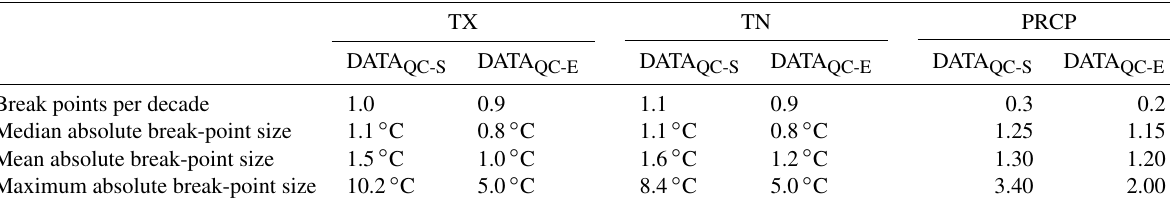
Table 4. Break-point frequencies and break sizes. For minimum and maximum temperature (TX and TN, respectively), absolute break size values in ◦ C are shown. For precipitation (PRCP), the factors of the break sizes are indicated.